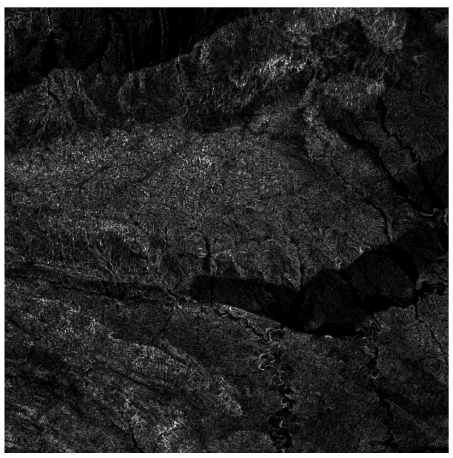
Figure 8. Diagram of a terrain roughness map. It is a 4096 × 4096 grayscale image.